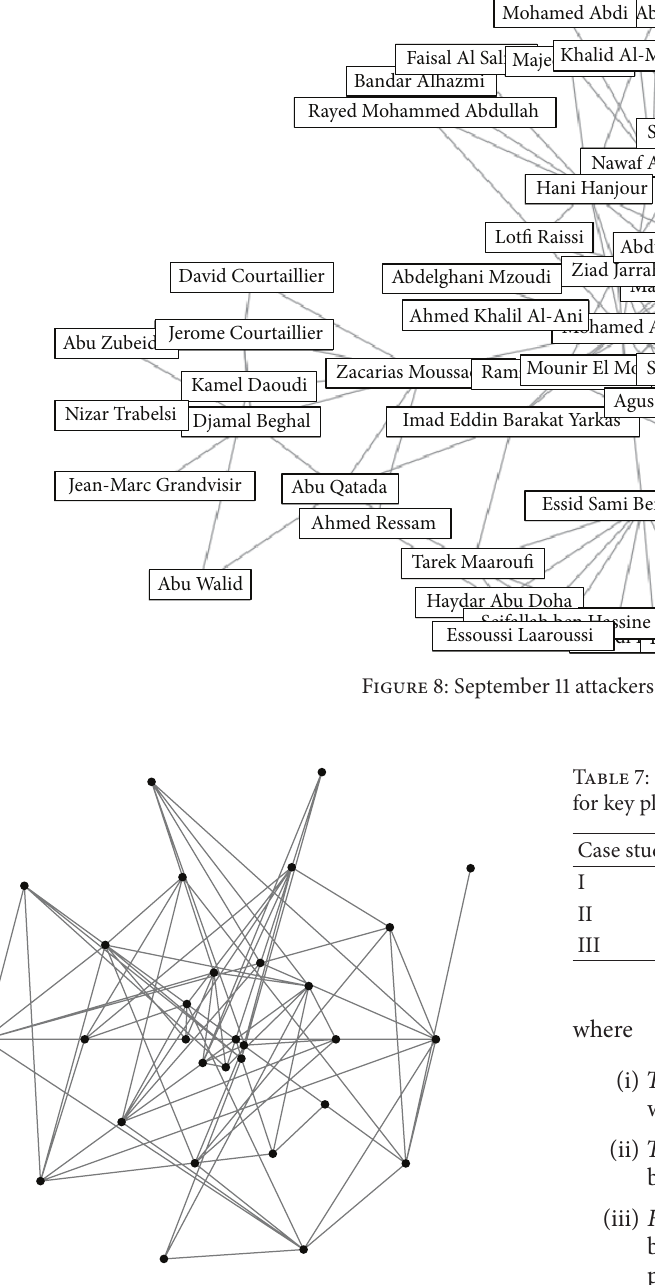
Figure 9: Cyber attackers network.